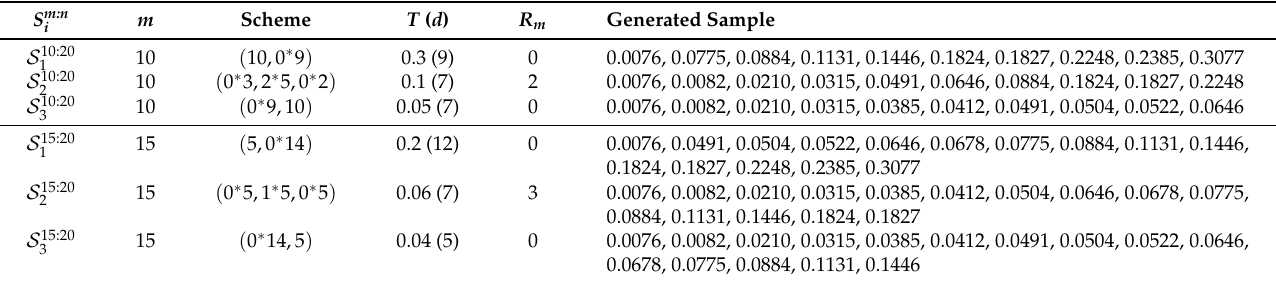
Table 5. Different AP-II-HC samples from SSB